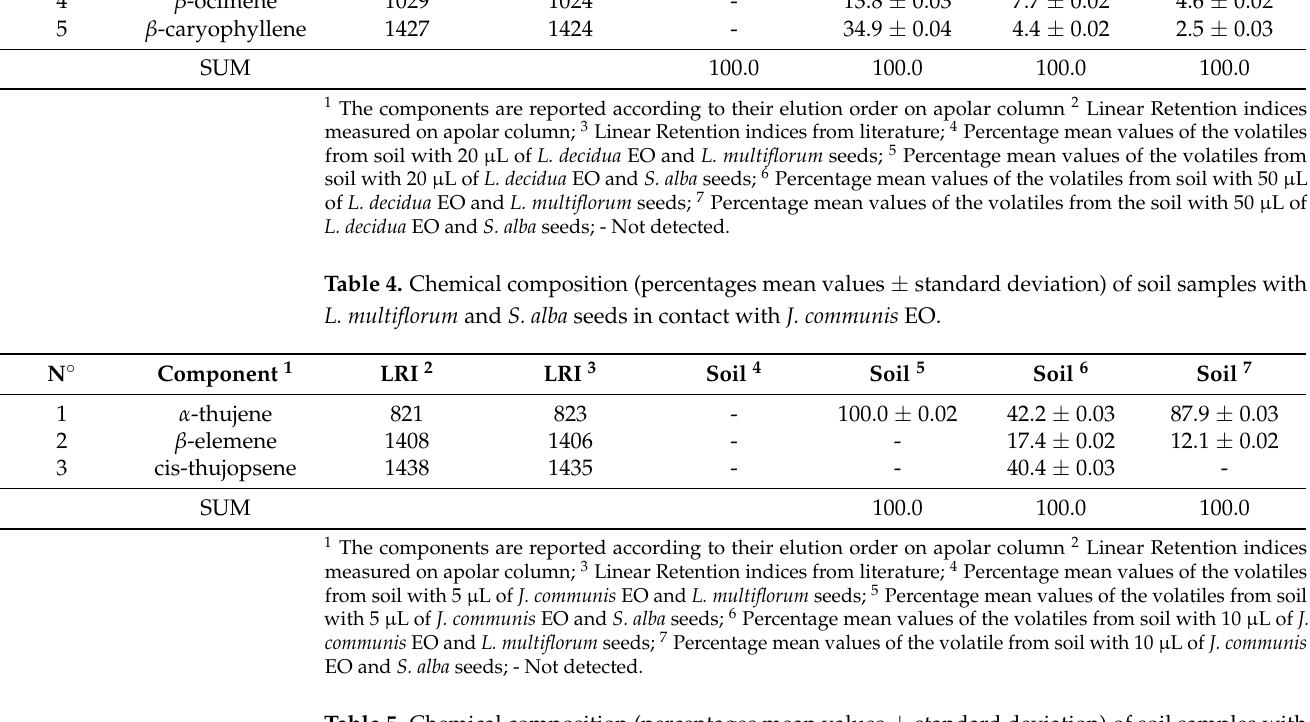
Table 5. Chemical composition (percentages mean values ± standard deviation) of soil samples with L. multiflorum and S. alba seeds in direct contact with L. decidua